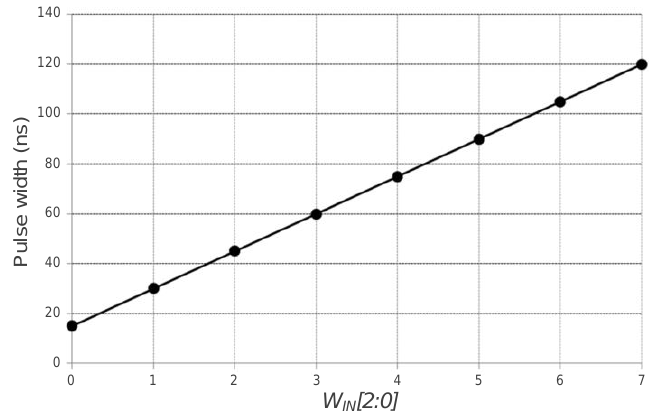
Figure 6. Simulated result of the pulse-width modulator for di ff erent weight code ( W IN ).